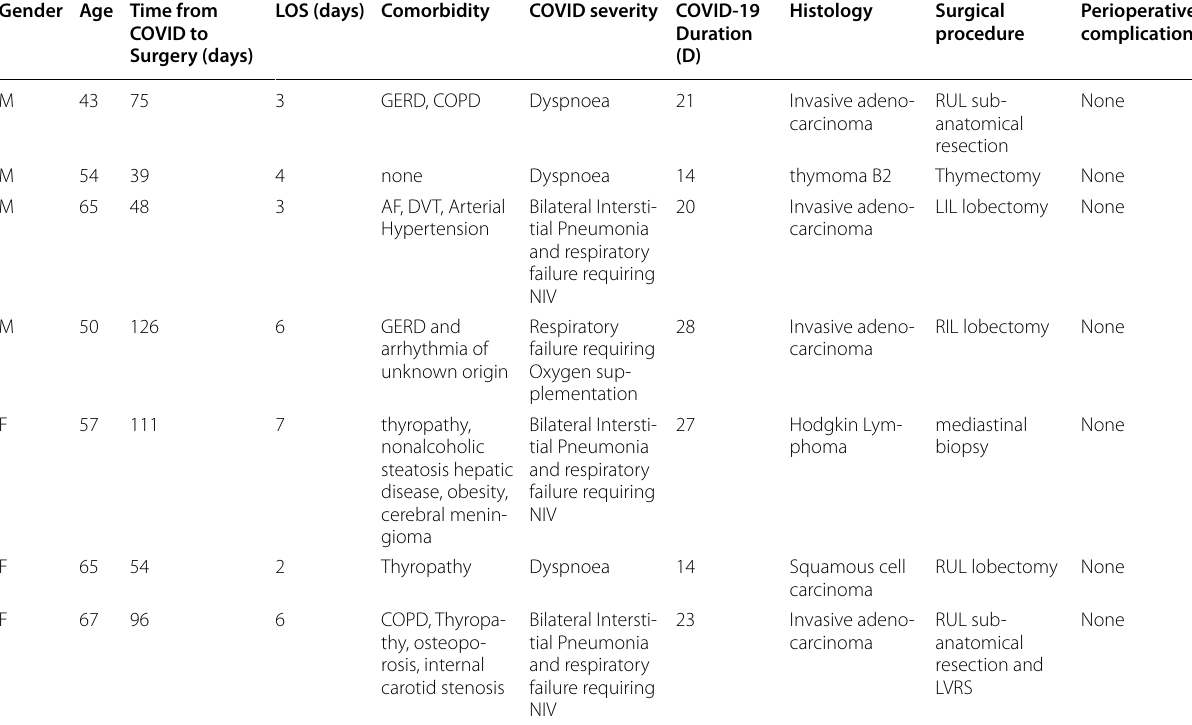
Table 3 Incidental findings during COVID-19 radiological diagnosis (AF atrial fibrillation; COPD chronic obstructive pulmonary disease; DVT deep vein thrombosis; GERD gastroesophageal reflux disease; LIL left inferior lobe; NIV non-invasive ventilation; RIL right inferior lobe; RUL right upper